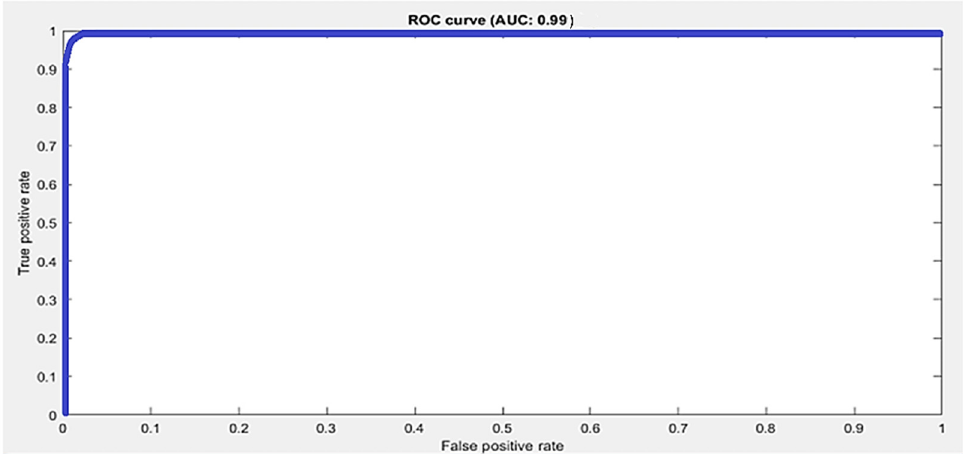
Figure 6. Macro average ROC curve and AUC score by the proposed approach using the First Person dataset.